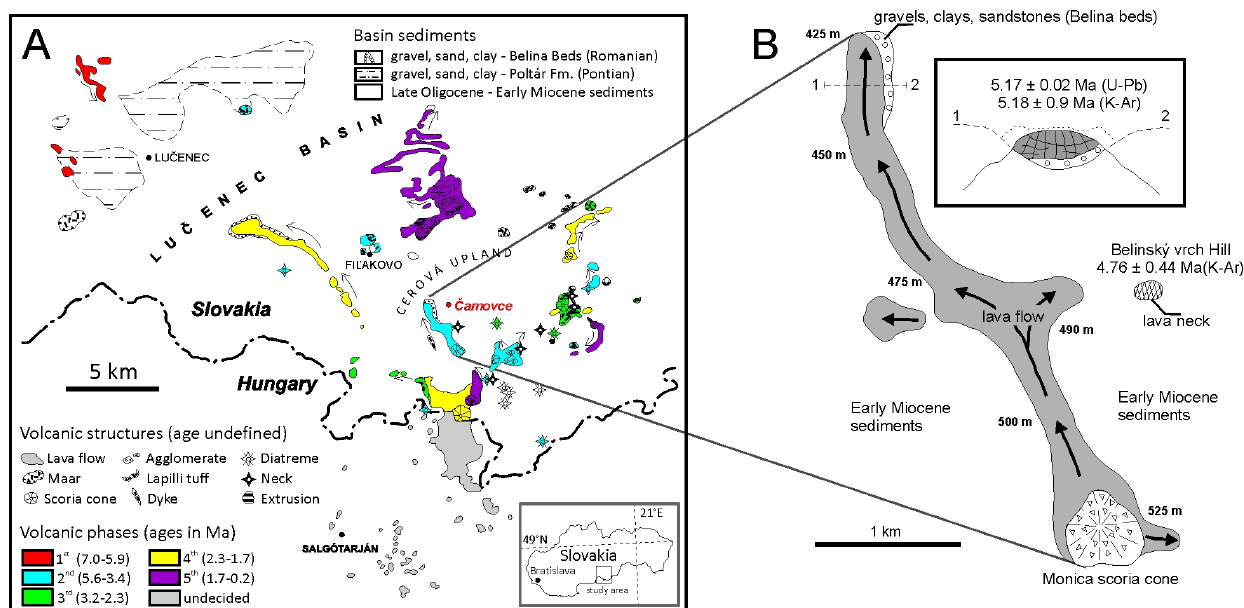
Figure 1. ( A ) Schematic map of the Southern Slovakia volcanic field, modified after [23]; ( B ) Enlarged view of the Belinsky vrch lava flow, lava neck and the Monica scoria cone. The 1–2 section transects the basalt quarry, where the xenoliths studied have been collected. Explanations: ( 1 )—cinder cone, ( 2 )—lava flow, ( 3 )—gravels and clays of Belina beds, ( 4 )—lava neck.